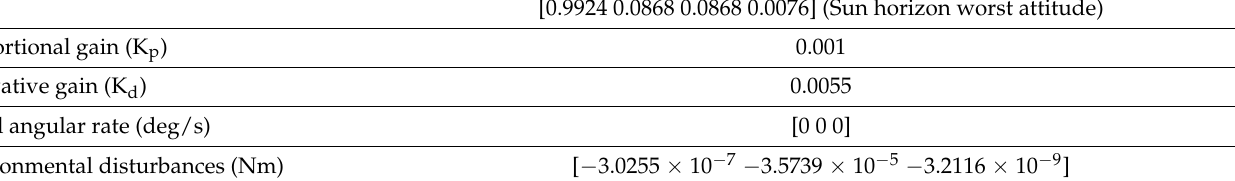
Table 8. Input values used to run the detumbling simulation.